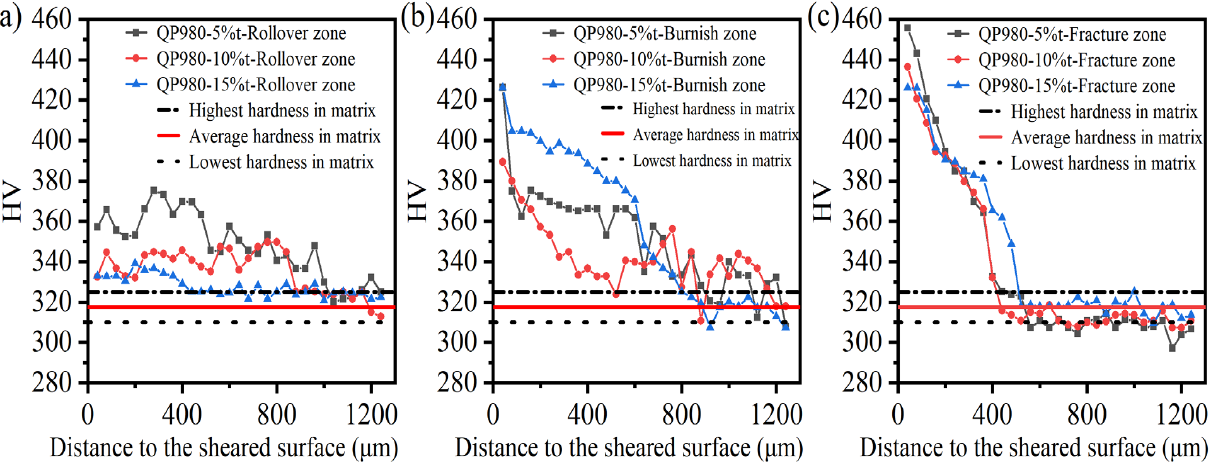
Figure 22. Microhardness distribution of sheared edge in different zones ( a ) rollover zone, ( b ) burnish zone, ( c ) fracture zone.